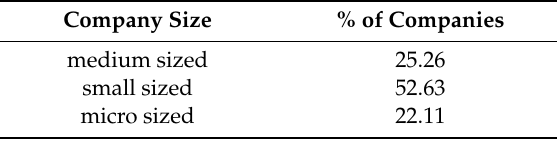
Table 2. Companies according to the size.